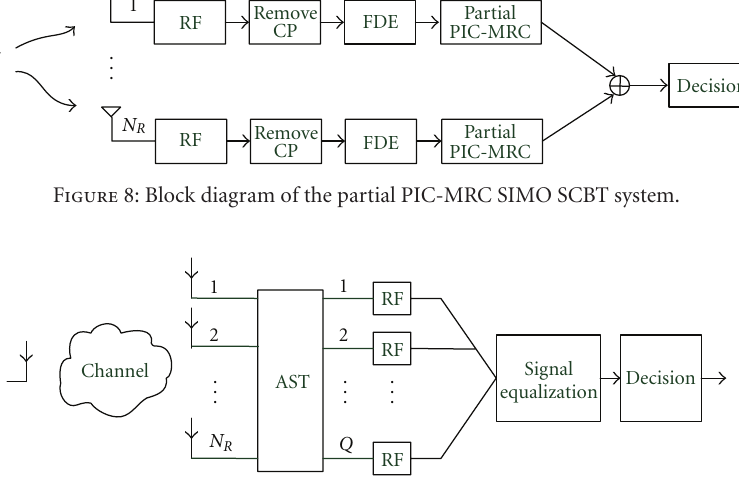
Figure 9: The structure of antenna selection with Q RF modules and N R receive antennas.